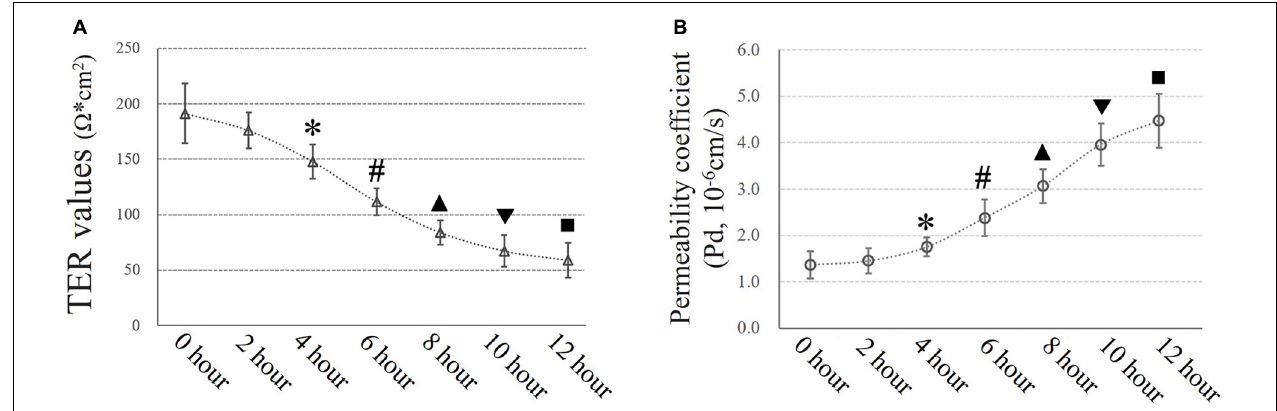
FIGURE 4 | Time-dependent high-pressure assay to assess TJ function. (A) TER values of HSAECs. ∗ P < 0.05, # P < 0.05, (cid:78) P < 0.05, (cid:72) P < 0.05, (cid:4) P < 0.05 vs. the initial (0 h) TER level, respectively. (B) Paracellular permeability assay for HSAECs. The results are described as permeability coefficients (Pd values). ∗ P < 0.05, # P < 0.05, (cid:78) P < 0.05, (cid:72) P < 0.05, (cid:4) P < 0.05 vs. the initial (0 h) Pd level, respectively.